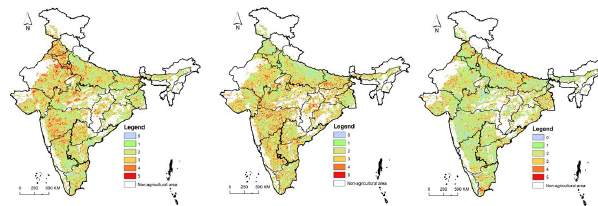
Figure 8 Frequency of Agricultural drought from 1982-1992, 1993-2002 and 2003-2015